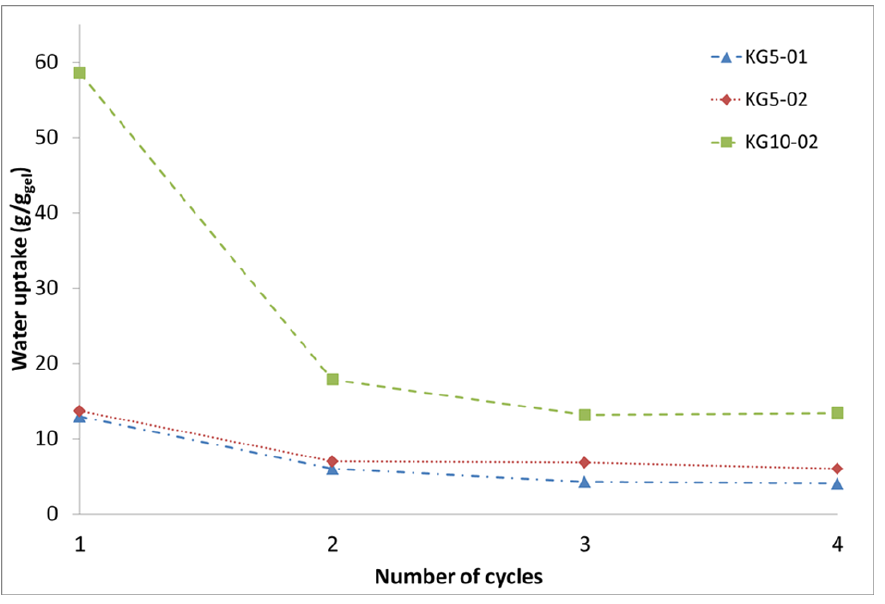
Figure 2. Trend in water uptake of keratin hydrogels in relation to their weight obtained after dry-